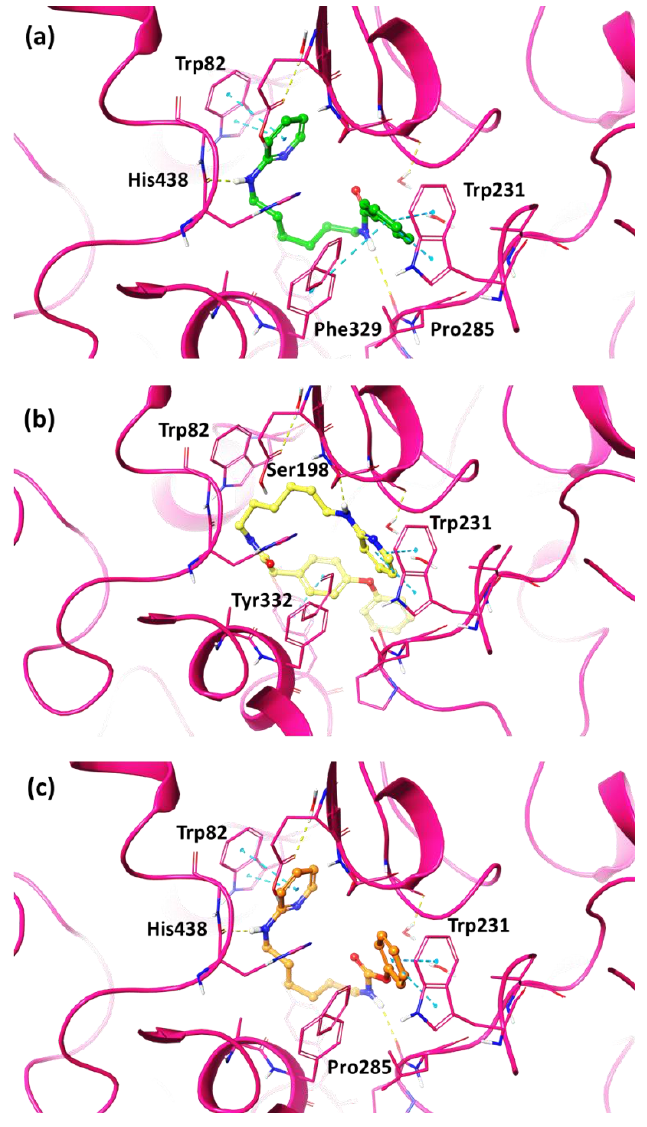
Figure 5. Best docking pose of compounds ( a ) 12 , ( b ) 14 , and ( c ) 18 into the h BChE active site shown as wire representation. Most relevant interacting residues are displayed as thin pink tubes. Compounds 12 , 14 and 18 are illustrated in green, yellow and orange carbon ball and stick representations, respectively. Hydrogen bonds and π – π interactions are, respectively, represented in yellow and blue dotted lines.